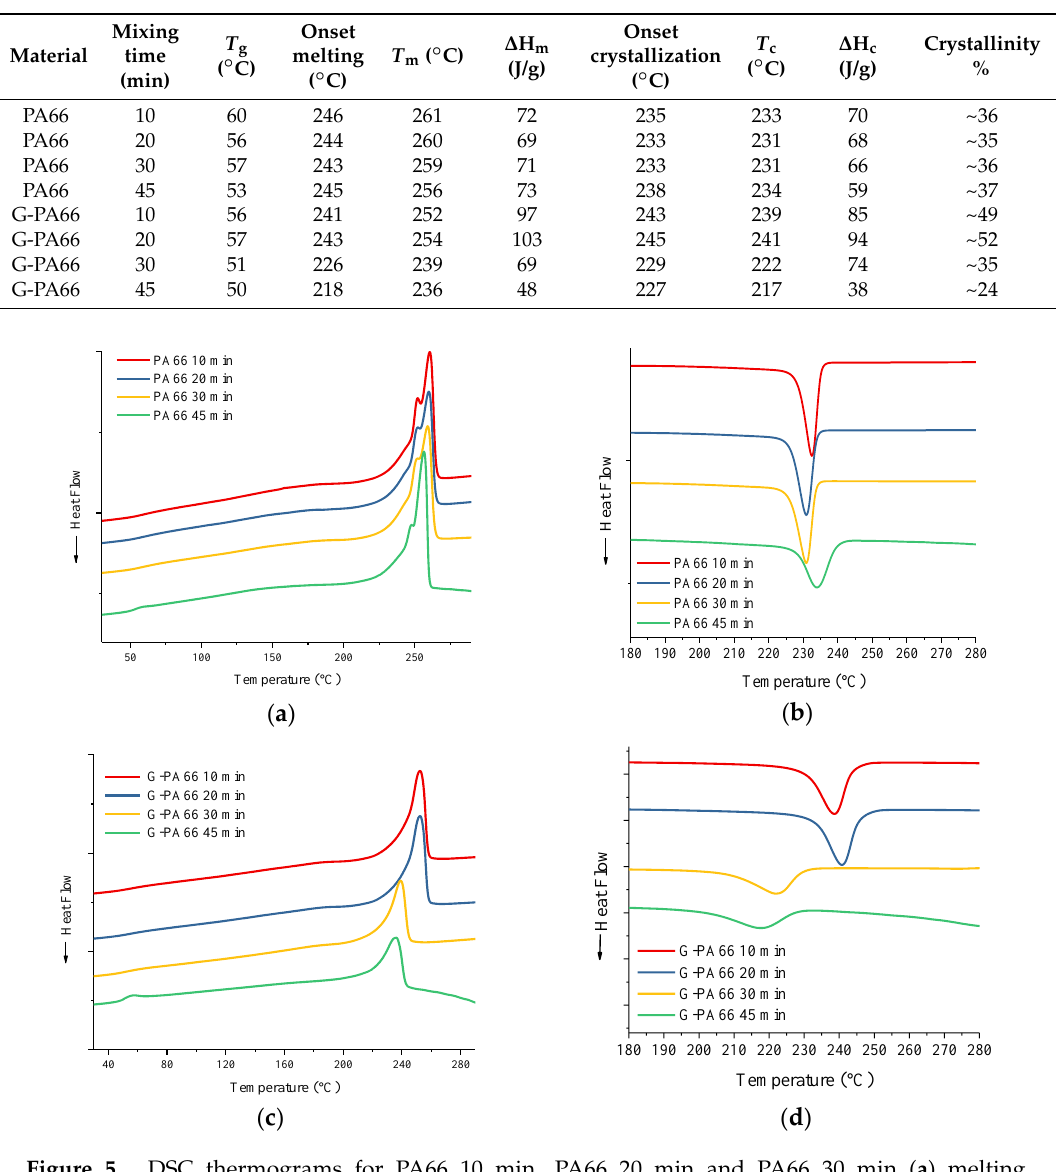
Figure 5. DSC thermograms for PA66 10 min, PA66 20 min and PA66 30 min ( a ) melting and ( b ) crystallization and for G-PA66 10 min; G-PA66 20 min and G-PA66 30 min ( c ) melting ( d ) crystallization.